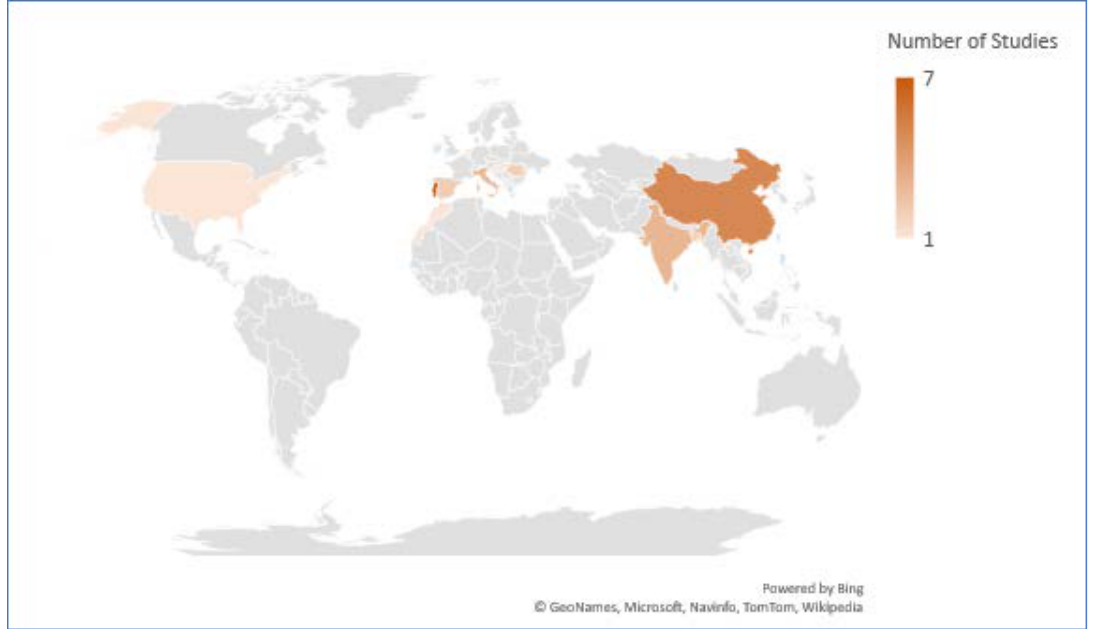
Figure 4. Distribution of studies from different locations of the world.